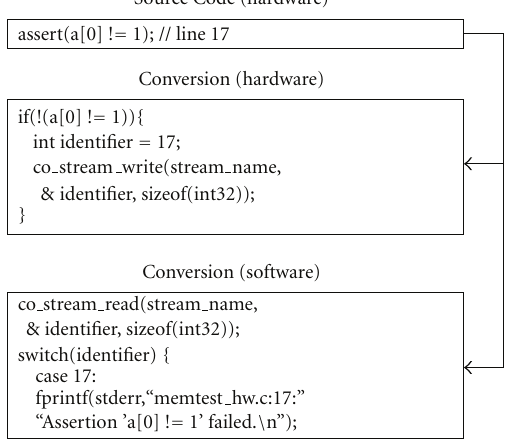
Figure 8: HLL assertion